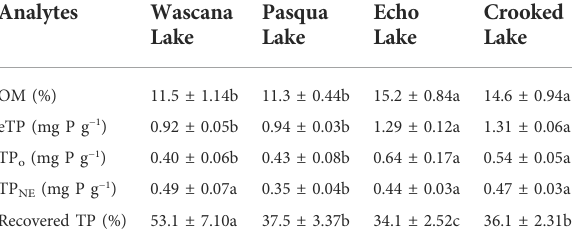
TABLE 1 Organic matter (OM), estimated concentrations per dry weight of total P (eTP), total organic P (TP o ), NaOH-EDTA- extracted TP (TP NE) and the proportion of eTP recovered in TP NE extracts (Recovered TP) of sediments from the sampled Qu ’ Appelle lakes,Saskatchewan,Canada.Valuesaretheconcentrationmeans (±SD); n =14(7depths,duplicatesedimentcoresamplesthatwere evenly mixed per depth). Different letters indicate signi fi cant differences ( p < 0.05) in concentrations of the nutrients, determined using Kruskal-Wallis tests followed by pairwise Wilcoxon tests with Bonferroni correction.